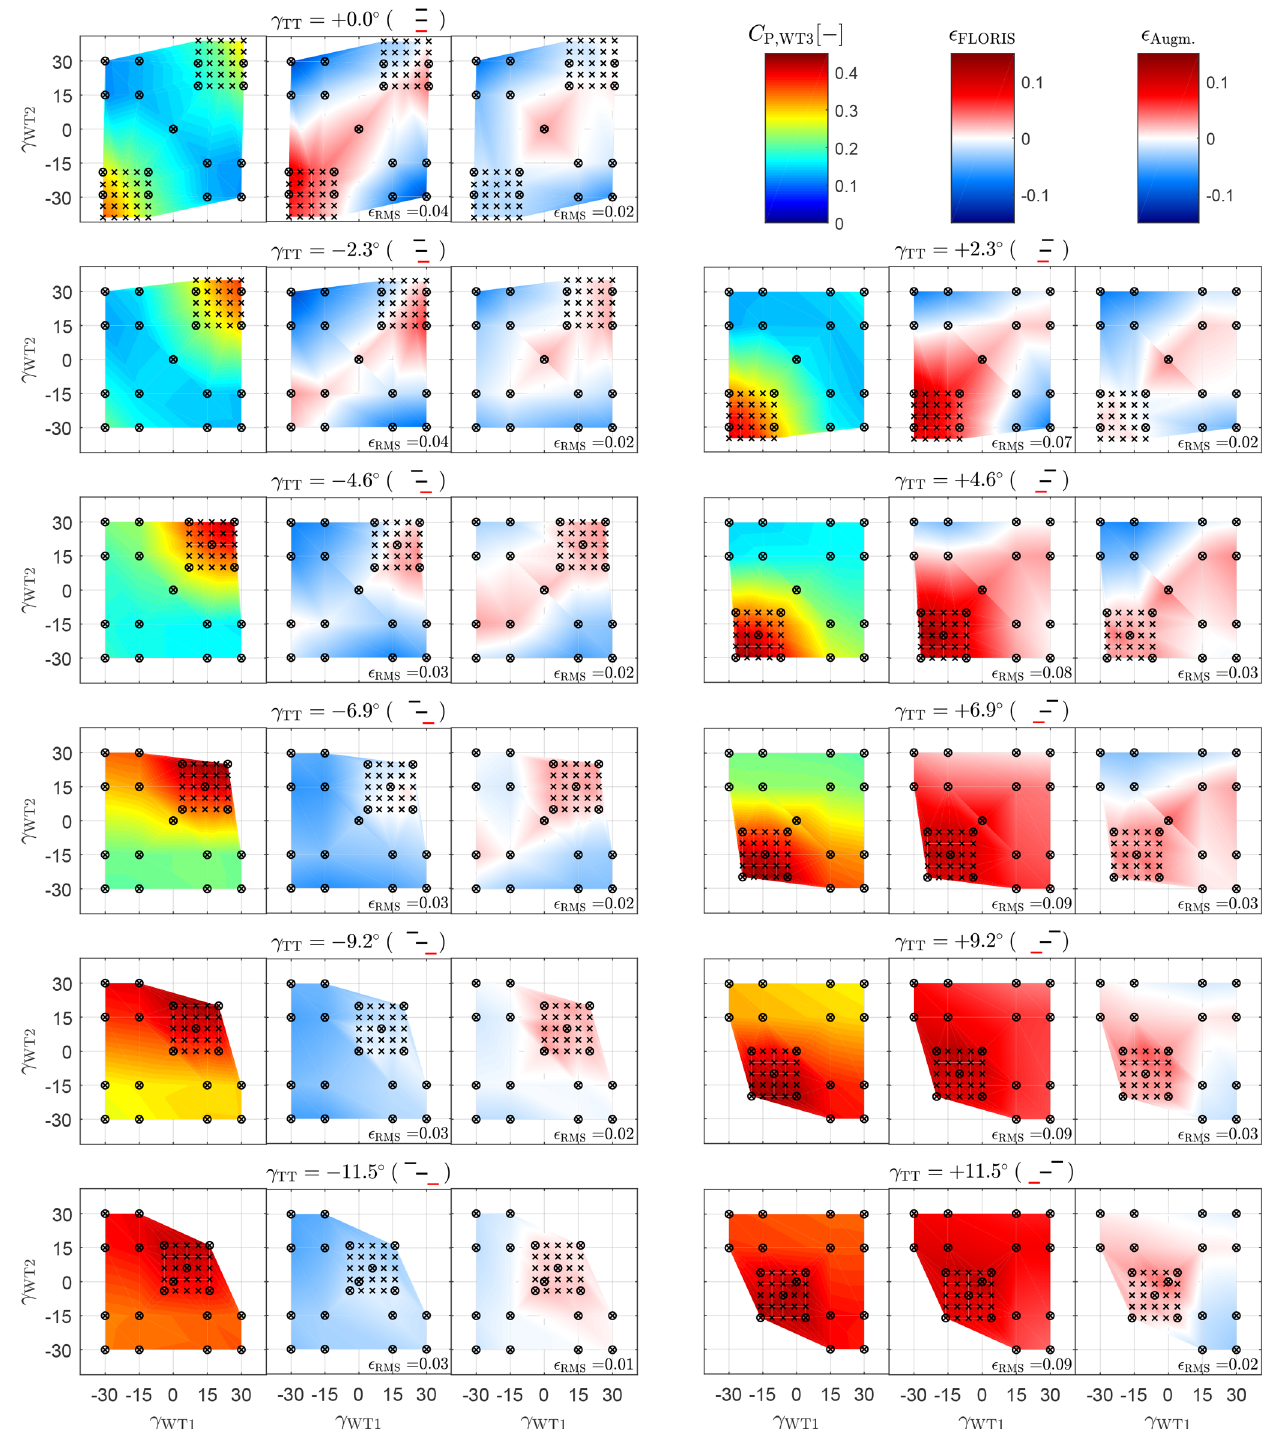
Figure A3. Wind turbine WT3. Each cluster of three subplots represents a unique turntable position, as indicated by the title and the wind farm layout sketch. Left subplot: turbine power coefficient C P , WT3 as a function of γ WT1 ( x axis) and γ WT2 ( y axis). Middle subplot: FLORIS model error. Right subplot: augmented model error. Cross symbols: all measured configurations. Circles: conditions used for parameter